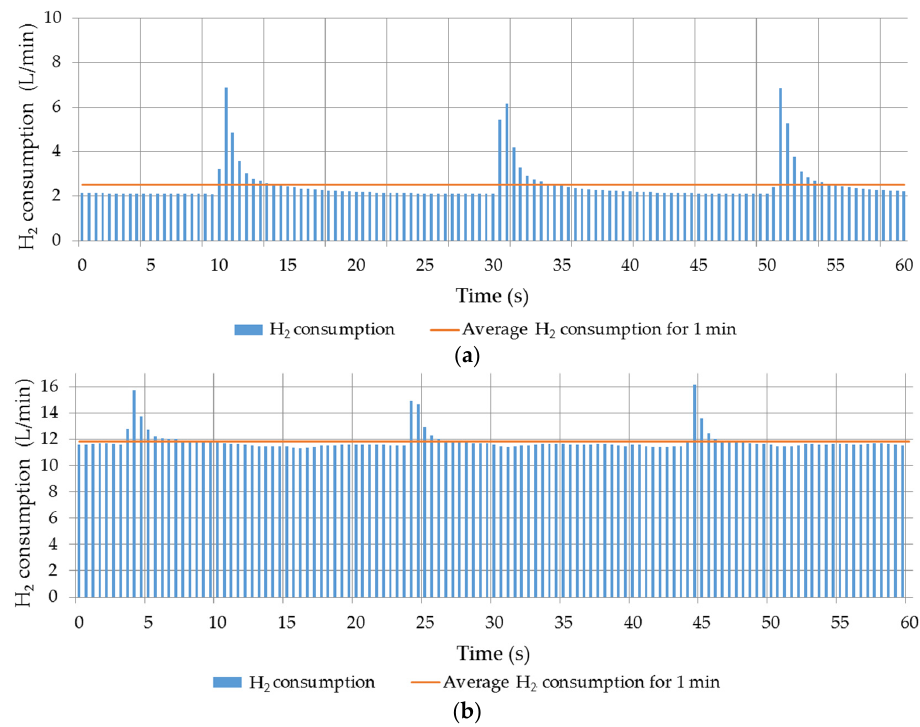
Figure 7. Hydrogen consumption per 1 min at p = 0.6 atm: ( a ) I PEMFC = 1 А ; ( b ) I PEMFC = 15 А . signal. The measurements were carried out when the load changed from 0 to 22 A in steps of 1 A (Figure 7).